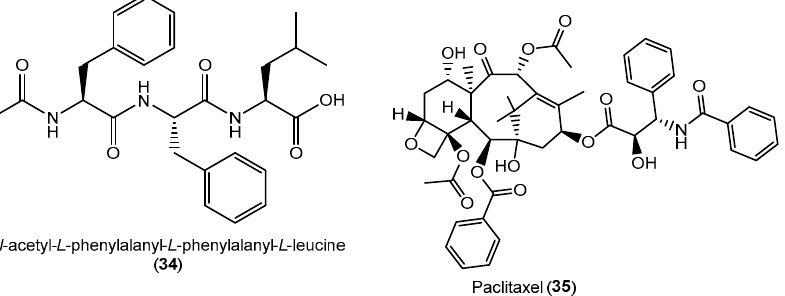
Figure 3. Metabolites isolated from endophytic fungi extracts exhibiting strong anticancer activity.